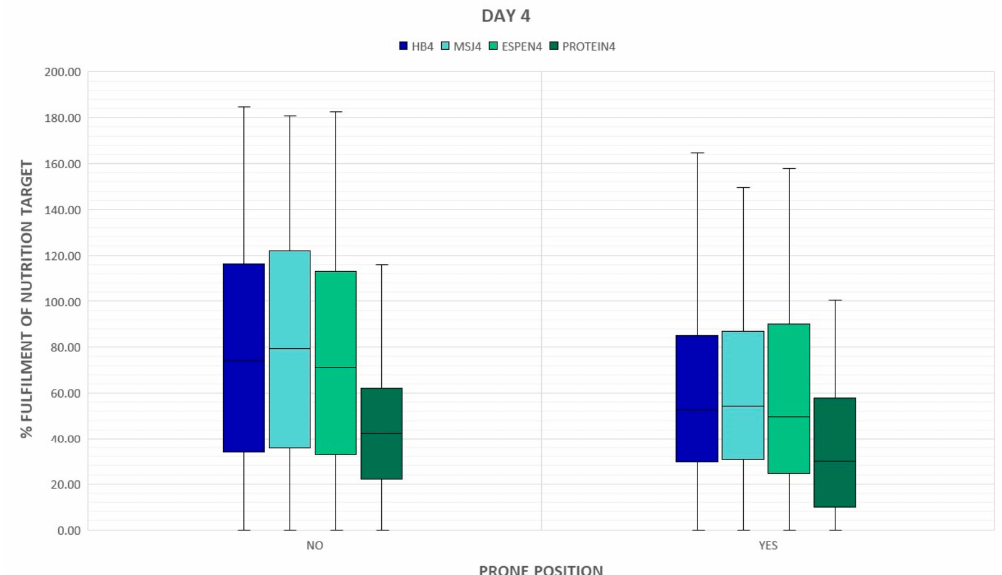
Figure 3. Prone positioning during ICU stay and delivery of energy and proteins on day 4. BH: Harris–Benedict equation; MsJ: Mifflin–St. Jeor equation; OX: passive oxygen therapy; NIV: non-invasive ventilation; IMV: invasive mechanical ventilation.